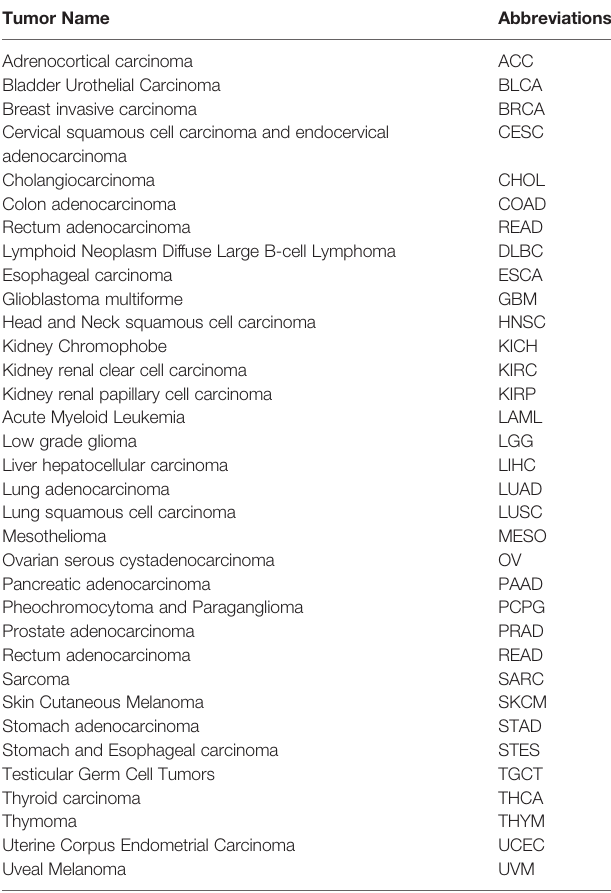
TABLE 1 | The abbreviations of tumors in pan-cancer